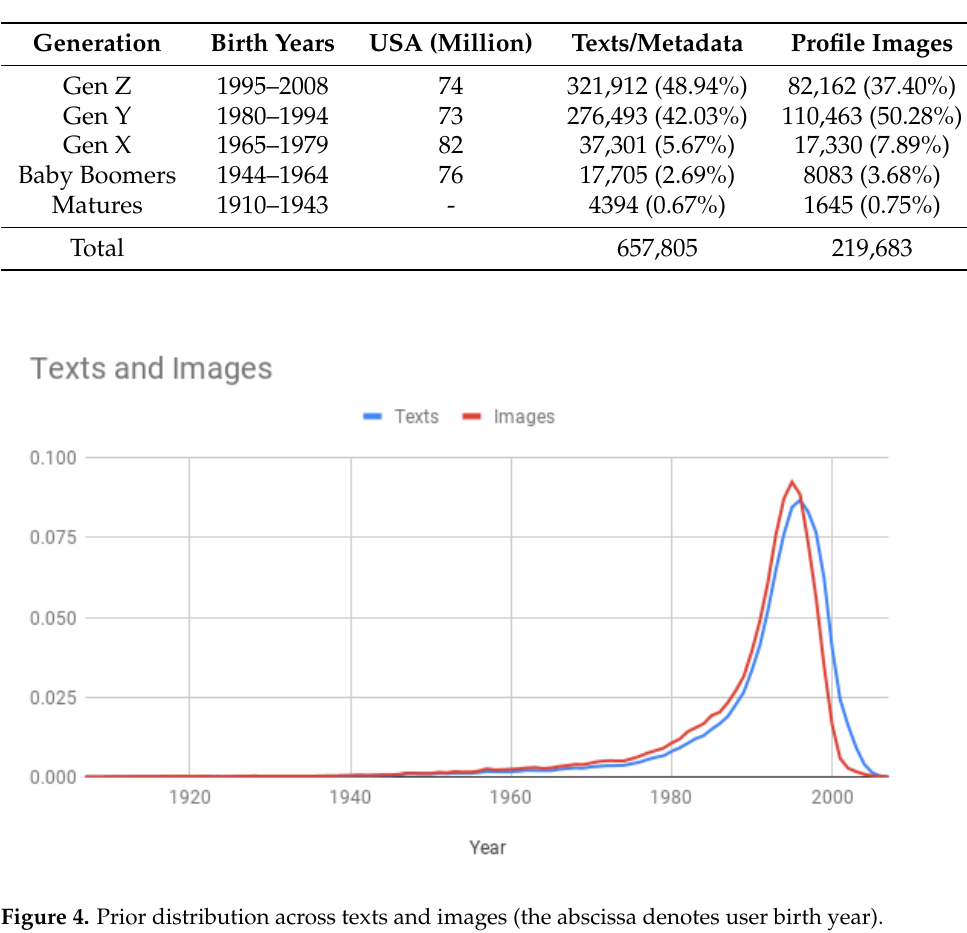
Table 1. Definitions and distributions of the different age clusters across the United States and our collection.